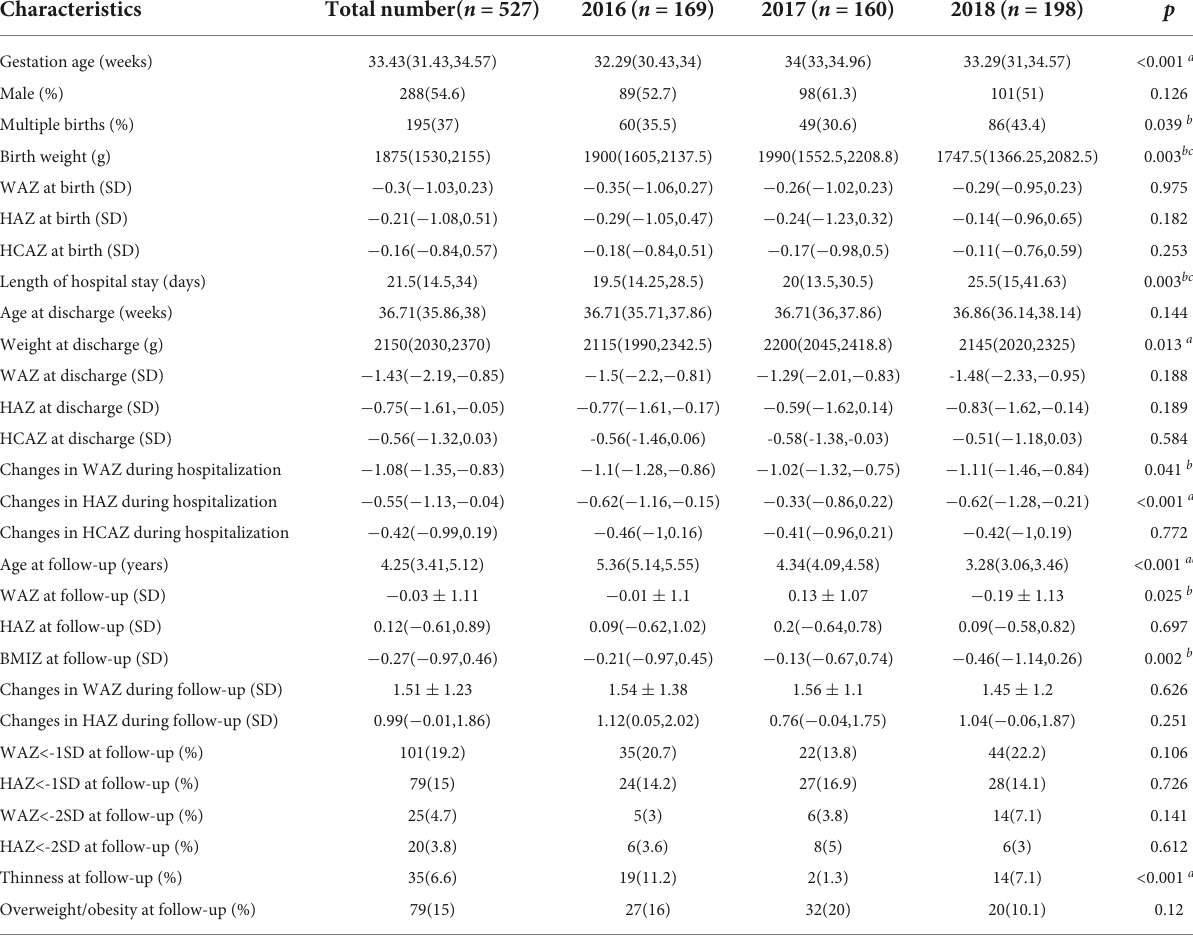
TABLE 1 The general characteristics of preterm infants before and after discharge.